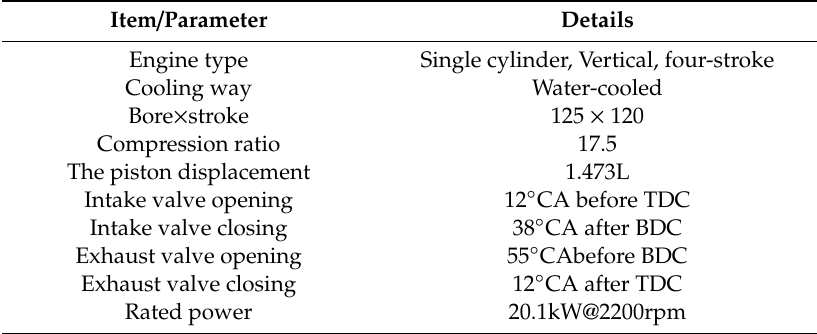
Table 2. Main engine specifications.